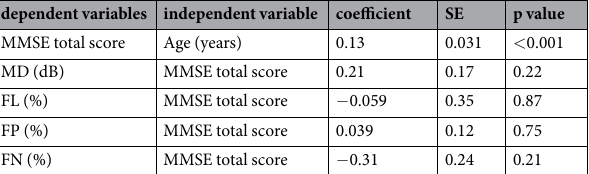
Table 2. The relationship between MMSE total score and age, MD, FL, FP, and FN. MMSE: Mini Mental State Examination, SD: standard deviation, MD: mean deviation, FL: fixation loss, FP: false positive, FN: false negative.